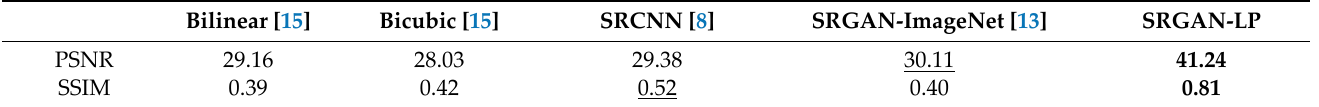
Table 2. Average PSNR (dB) and SSIM of 100 reconstructed test images for the synthetic test set. Bold scores show the best results, and underlined values represent the second best results.